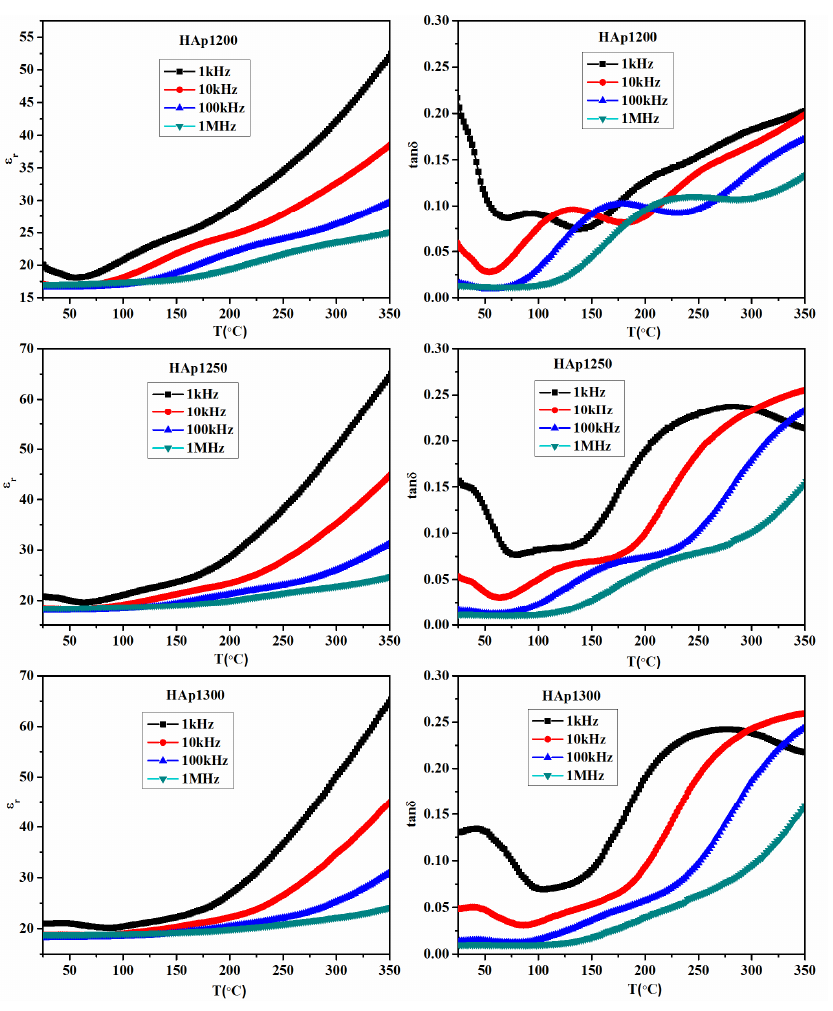
Figure 6. Variation in εr and tanδ (at different frequencies) with the temperature of sintered HAp samples.